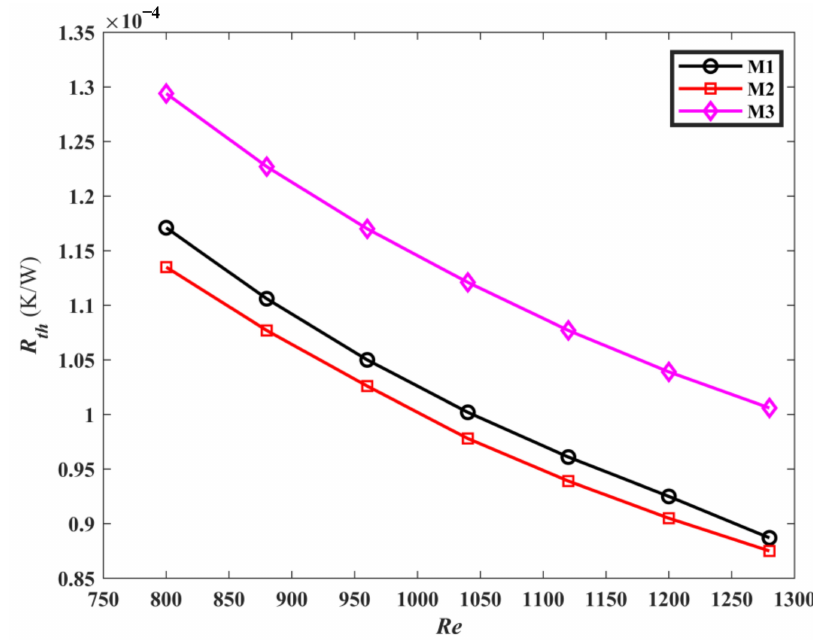
Figure 13. The R th of the three mini-channels varies with Re